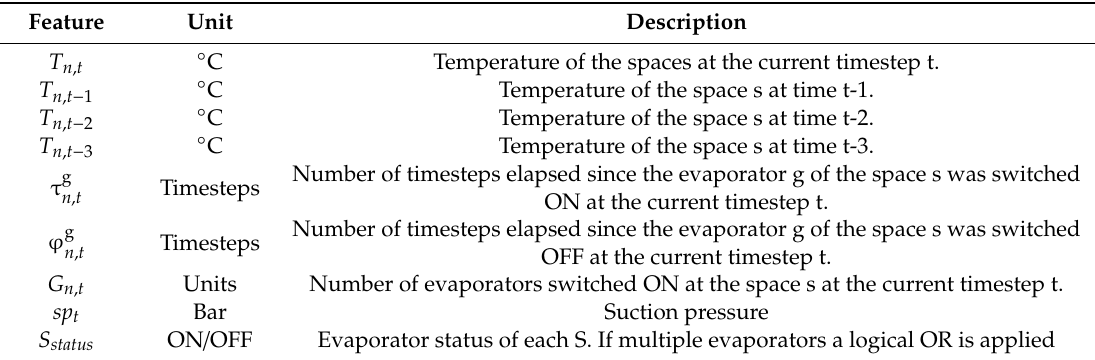
Table 2. Features employed for the disaggregation